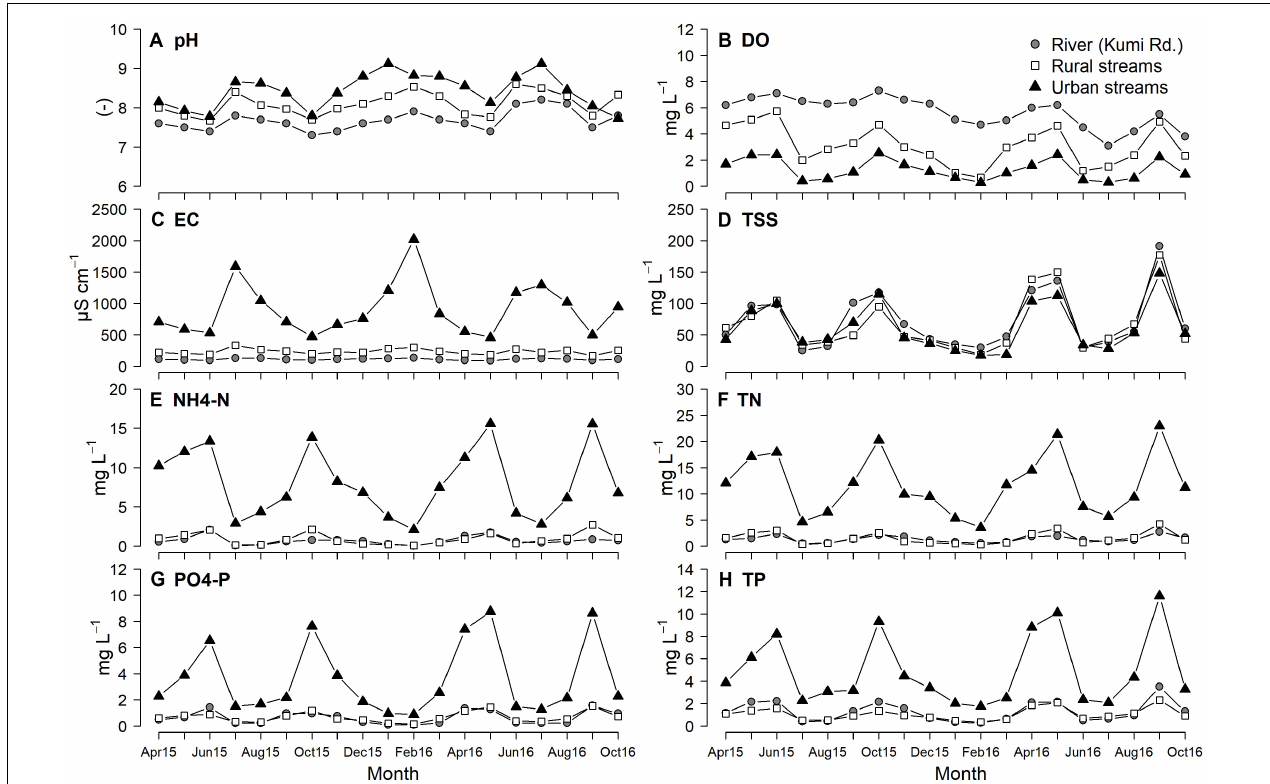
FIGURE 7 | Variation of water quality parameters in Namatala River (at the Kumi Road sampling point), urban streams (mean value of four streams) and rural streams (mean value of three streams) of Namatala Wetland, Uganda, in the period April 2015–October 2016. (A) pH; (B) dissolved oxygen (DO); (C) electrical conductivity (EC); (D) total suspended solids (TSS); (E) ammonium nitrogen (NH 4 -N); (F) total nitrogen (TN); (G) soluble reactive phosphorus (PO 4 -P); (H) total phosphorus